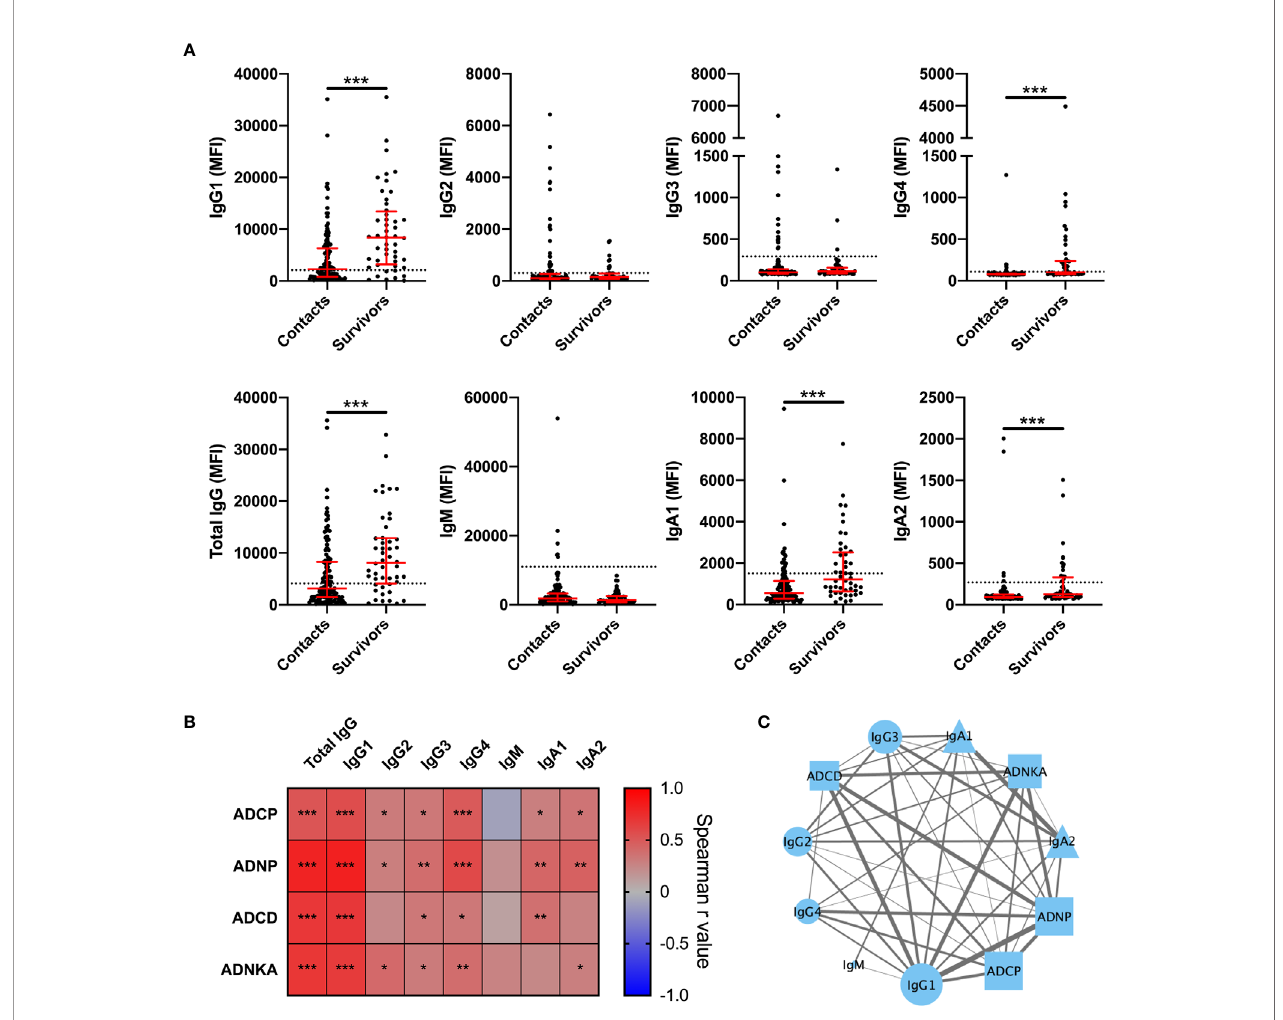
FIGURE 2 | GP speci fi c IgG1 levels are strongly associated with antibody effector functions in BDBV survivors. Levels of BDBV GP speci fi c IgG1, IgG2, IgG3, IgG4, total IgG, IgM, IgA1, and IgA2 in plasma of BDBV survivors (n=48) and household contacts (n=121) (A) . The line and whiskers represent the median and interquartile range respectively. The dotted line represents the cutoff for positivity. Heatmap showing the associations between antibody subclasses or isotypes and antibody effector functions (B) . Correlation network analysis of statistically signi fi cant associations (p < 0.05) between GP-speci fi c functional activity and levels of GP-speci fi c antibody levels (C) . The strength of correlation is indicated by the weight of the connecting line and the number of signi fi cant associations for each feature is represented by the size of the icon. IgG and IgA subclasses are represented by circles and triangles respectively. IgM is represented by a diamond and Fc-mediated functions are represented by squares. *** represents p values < 0.001, ** represents p values < 0.01, and * represents p values <